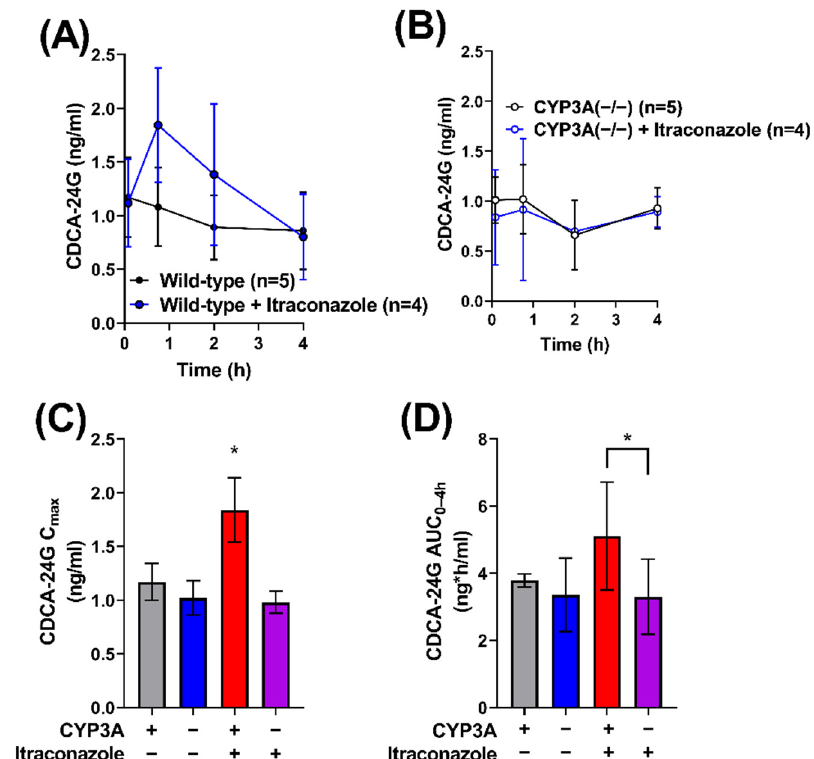
Figure 4. Itraconazole-induced increase in OATP1B biomarker is dependent on CYP3A. CDCA-24G concentrations were measured in serial plasma samples were collected and from female ( A ) wild- type and ( B ) CYP3A( − / − ) mice that were untreated or treated with itraconazole. Samples were analyzed for concentrations of CDCA-24G, an endogenous biomarker of OATP1B transporter function, via LC-MS/MS, and the ( C ) maximum plasma concentration (C max ) and ( D ) area under the concentration–time curve (AUC) using the last observed timepoint (AUC 0–4h ) were estimated with non-compartmental analysis (NCA) using Phoenix WinNonlin 8.1. Data are shown as mean (symbols or bars) and SD (error bars). ∗ p < 0.05 Table 2. CDCA-24G pharmacokinetic parameters.